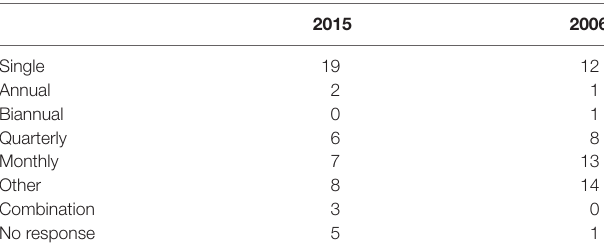
Table 4 | Comparison of the number of states by reimbursement schedules.